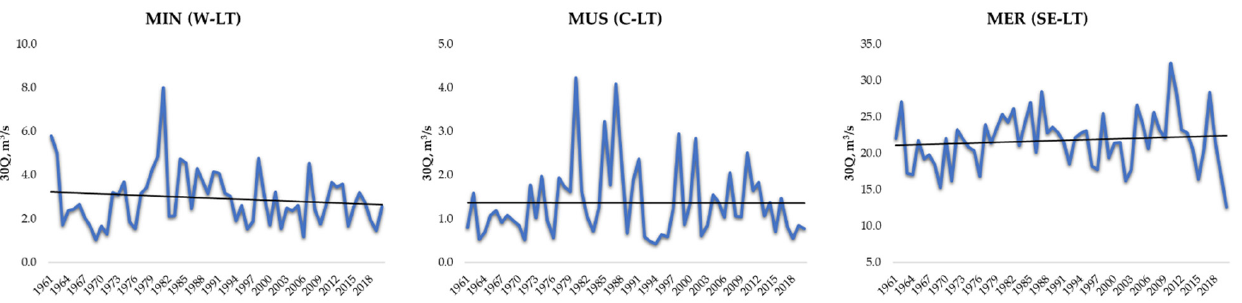
(Figure 6). In the W-LT region, 30Q tended to decrease; on the contrary, 30Q had tendency to increase in the SE-LT region. There was no trend detected in 30Q of MUS from the C-LT region.